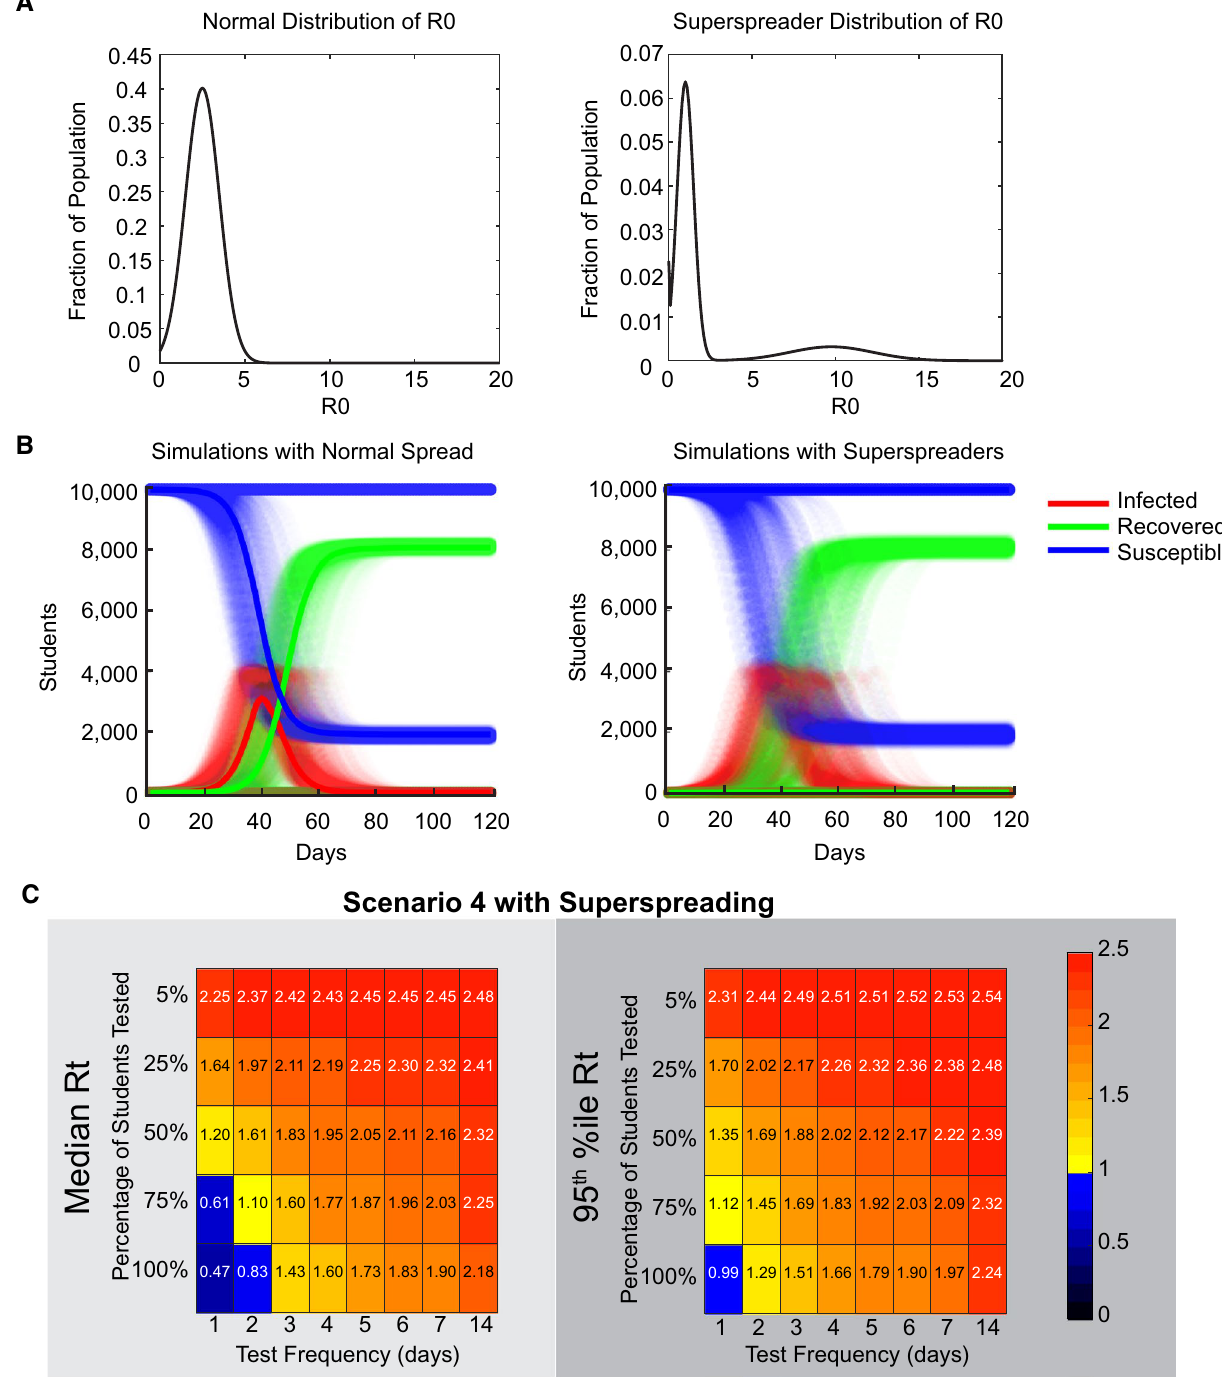
Figure 8. Superspreading leads to more variability between discrete simulations, but requires the same amount of testing as normally distributed transmission probabilities. ( A ) On the left is the normal distribution of R0s assigned to individuals, while the right distribution is a superspreader distribution where 20% of the population is responsible for 80% of the infections. ( B ) 500 runs of the model with either the normal distribution or the superspreader distrubtion of R0s and the Scenario 4 transmission and false negative rate dynamics. Medians of each population are shown as solid lines. Note that the medians of infected and recovered in the superspreader conditions fall on the x-axis line. ( C ) Effective reproduction number (Rt) for the indicated testing frequency and proportion of population for the superspreader R0 distribution. As in Fig. 5, only daily testing of 100% of individuals is sufficient to drive Rt below 1 under these